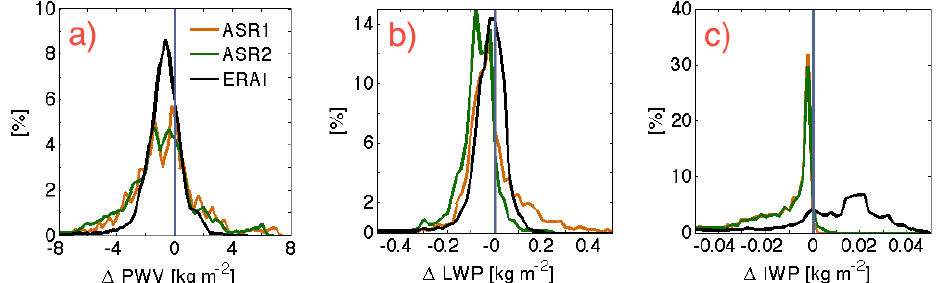
Fig. 9. Histograms (%) of the difference between each reanalysis and the ASCOS observations for the variables in Fig. 8: (a) precipitable water vapor (PWV), (b) liquid water path (LWP) and (c) ice water path (IWP), all in kgm −